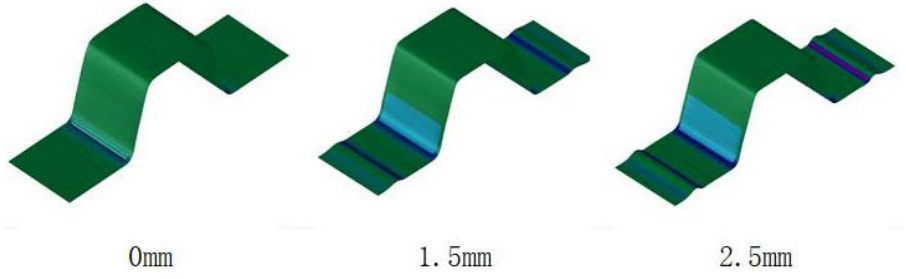
Figure 21. Skid line display at different drawbead height.